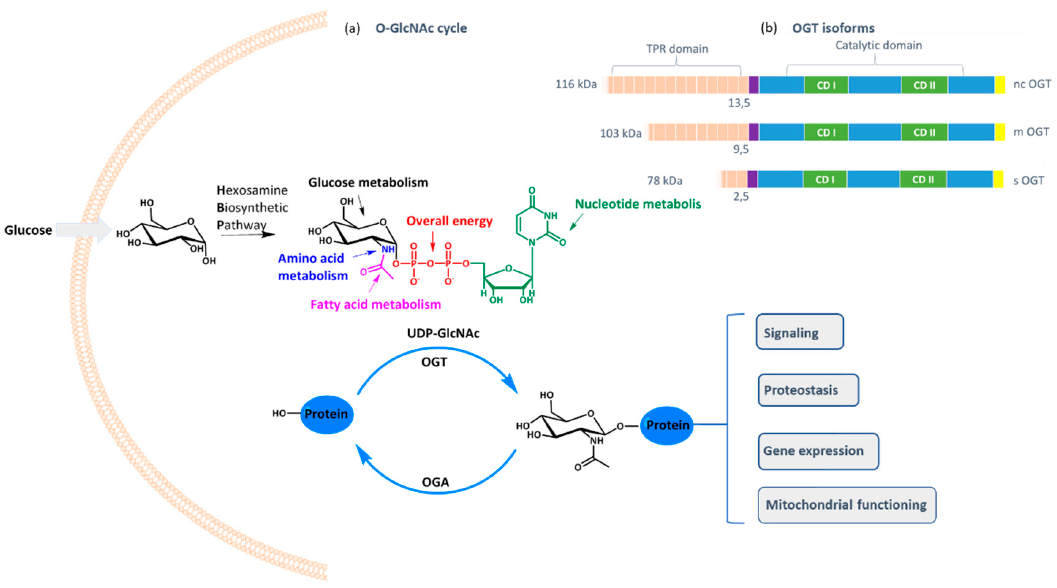
Figure 1. ( a ) Schematic representation of O -GlcNAcylation cycle. Approximately 2–3% of the cellular glucose enters the hexosamine biosynthetic pathway (HBP), leading to the formation of UDP-GlcNAc. OGT uses the latter as a glycosyl donor to glycosylate serine and threonine residues of hundreds of proteins, while OGA removes the GlcNAc moiety. OGT activity reflects the cell nutritional status and influences many critical cellular processes. ( b ) Schematic structure of OGT isoforms. The three splice isoforms of OGT, ncOGT, mOGT and sOGT, possess identical catalytic region but differ in the number of tetratricopeptide repeats (TPR) at the N -terminus.